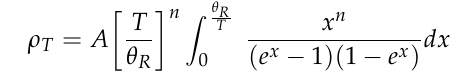
Figure 3. Backscattered electron (BSE) image of ex − situ recovered Au sample at 10 GPa and ∼ 1800 K along with a plot of line profile of electron microprobe (EPMA) results. The line from point 1 to 69 was divided into units and each unit measured about ~10 − 14 µm.